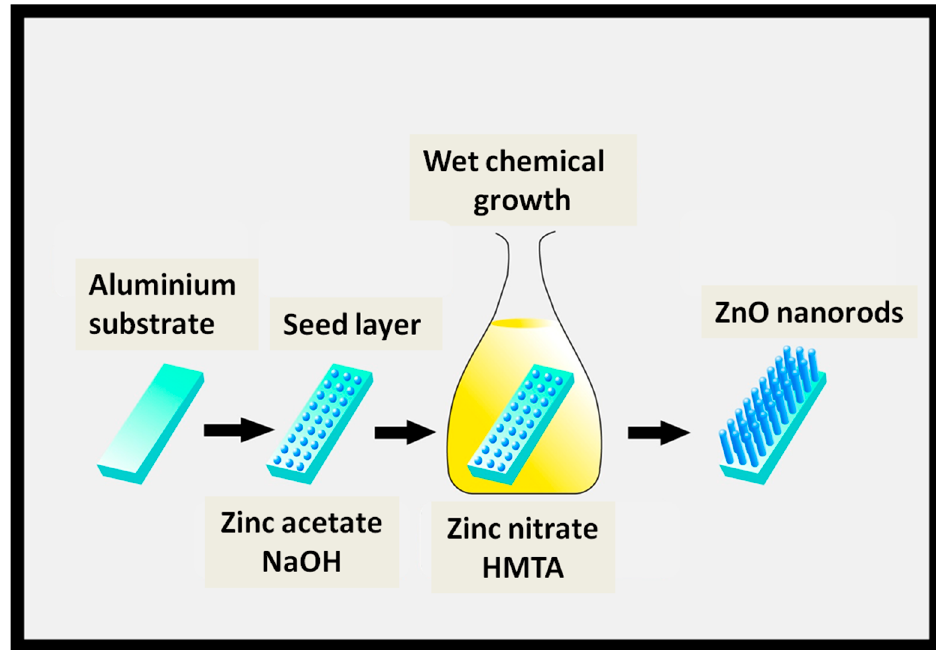
Figure 1. A Schematic diagram for the growth of ZnO nanorods on Al substrate.